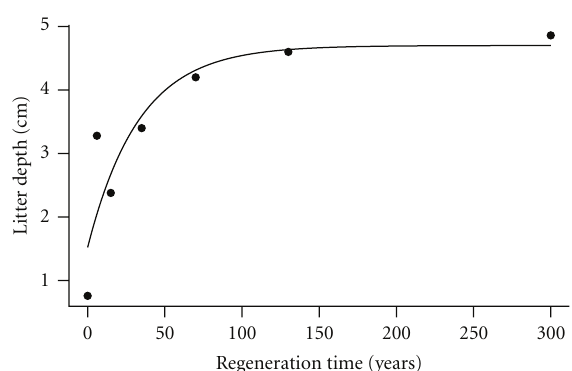
Figure 6: Response of litter depth to regeneration time. Litter depth increased asymptotically up to 130 years of regeneration. Nonlinear regression with Gaussian errors: y = e (0 . 894+0 . 328 ∗ x ) ; F 2,4 = 8.78; P = 0 . 034.